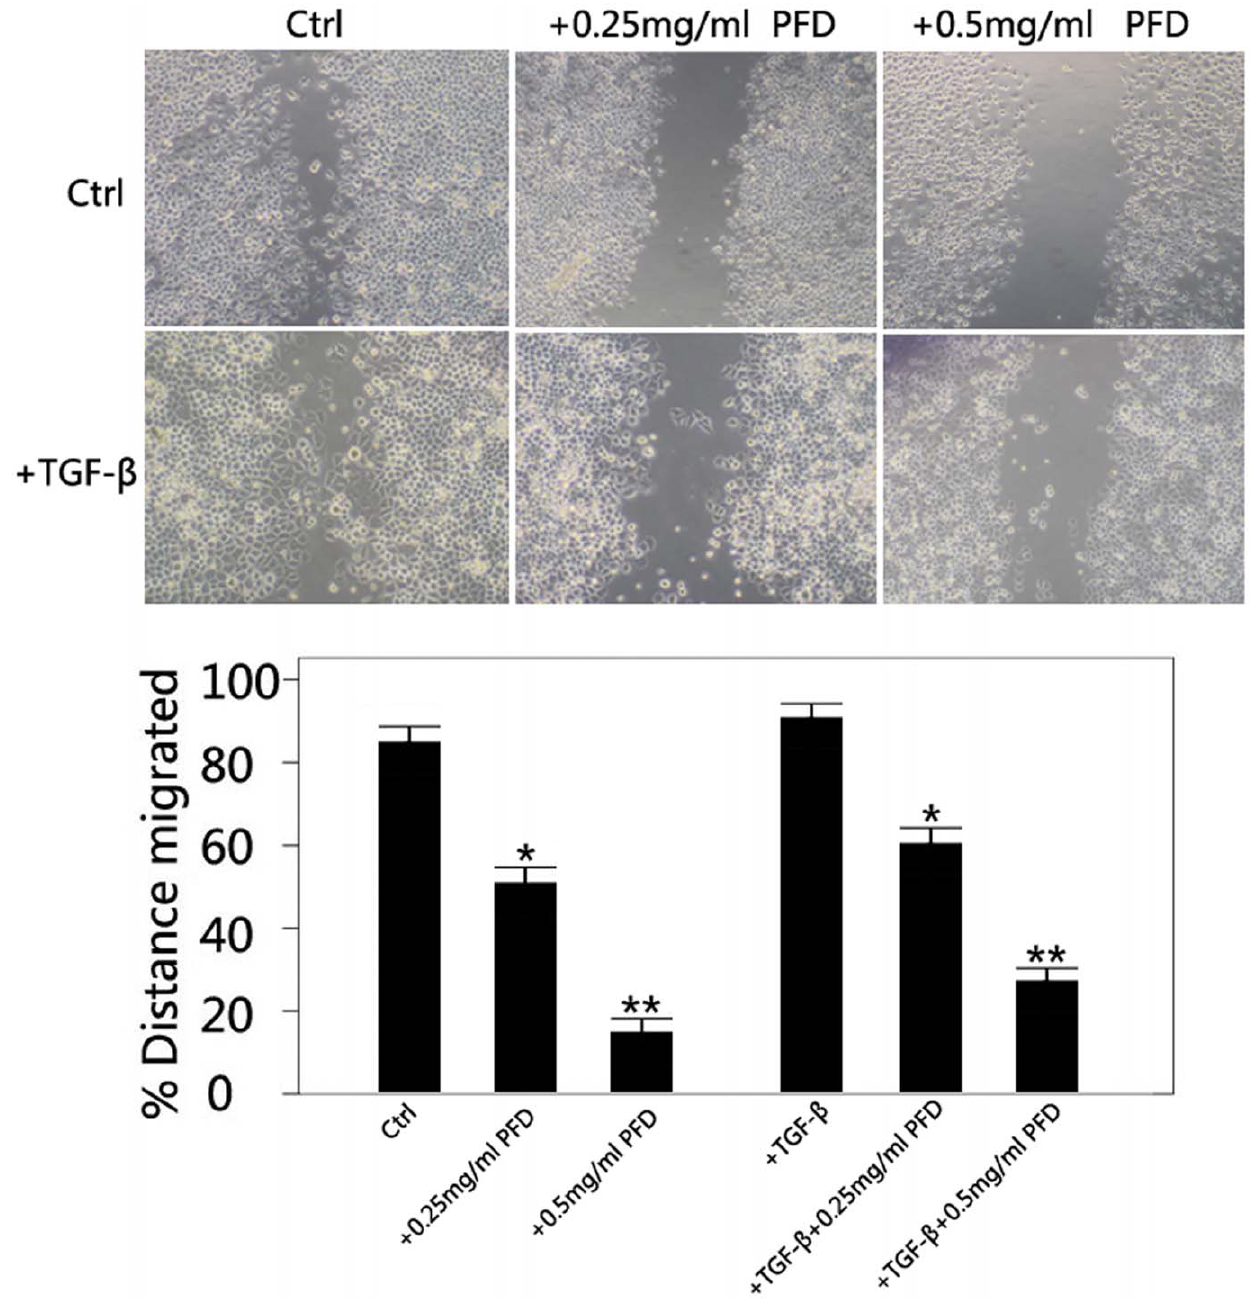
Figure 6. Inhibitory effect of pirfenidone on TGF- b 2-induced migration of SRA01/04 cells. Light microscope images show decreased migratory ability of cells at 24 hours, after scratches were applied to the cells with 0, 0.25, or 0.5 mg/mL pirfenidone in the absence or presence of TGF- b 2. *P , 0.05 and **P , 0.01 versus the corresponding value for control cells. Data in each bar are the mean 6 SD of cells that migrated through the membrane in three separate experiments. Magnification, 6